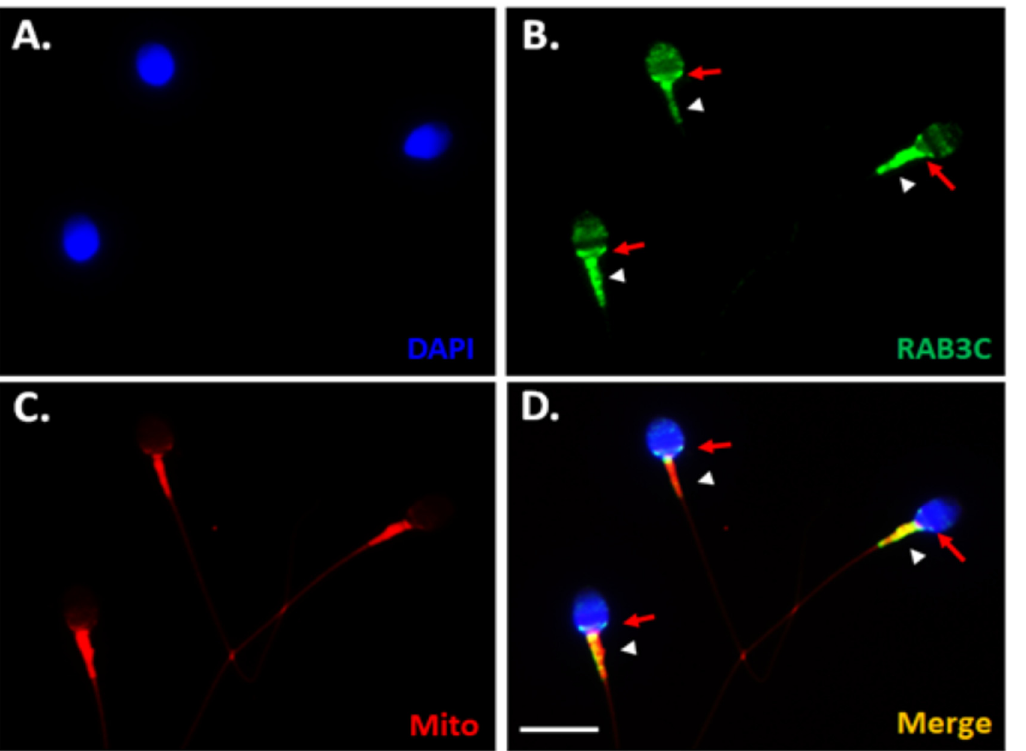
Figure 1. Localization of RAB3C in human spermatozoa. ( A ) Localization of sperm nuclei by DAPI staining. ( B ) Signals of RAB3C protein (green) localized at the postacrosomal region (red arrows) and midpiece (white arrowhead) in the human sperm. ( C ) MitoTracker (red) staining. ( D ) Merged immunofluorescence staining image ( A – C ). (Scale bar: 10 μ m).